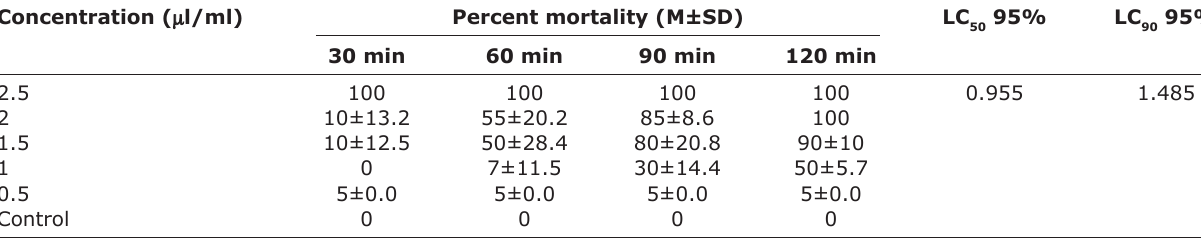
Table-3: Toxicity of Piper betle L. essential oil to adult A. aegypti . Concentration ( µ